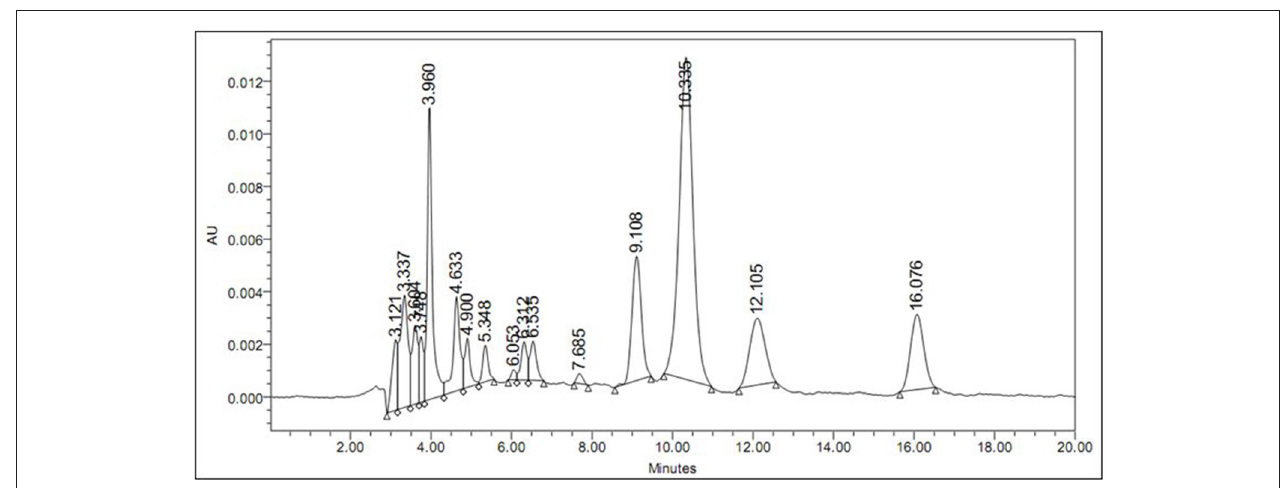
FIGURE 1 | HPLC chromatogram of binder (PS001) extract containing DM (Rt = 16.076 min).